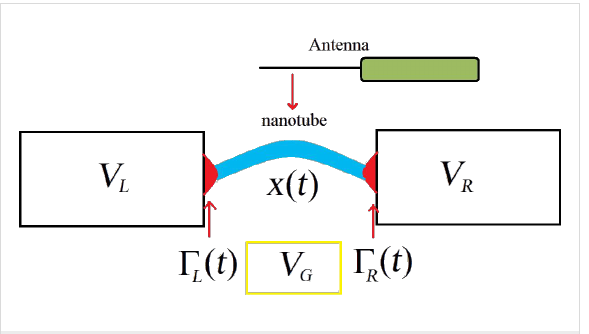
Figure 9: Sketch of the device investigated in section 6. A carbon nanotube is suspended between two metal leads to which a bias voltage V L = − V R = V bias /2 is applied. The motion of the nanotube is activated by an external antenna. The contact giving the gate